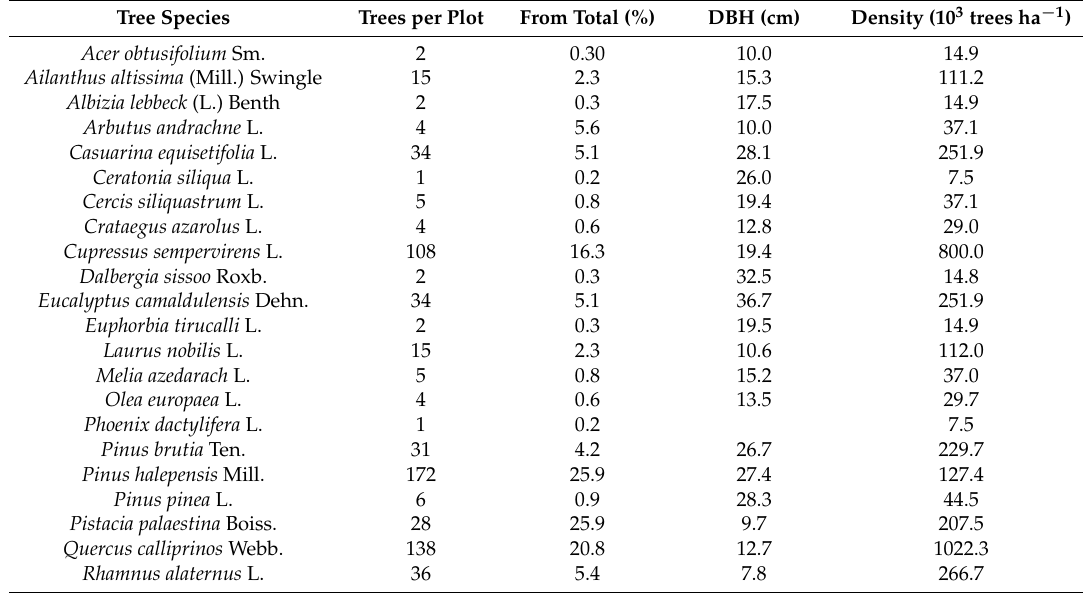
Table A1. Tree species distribution in urban (UR; top) and wildland (WLD; bottom) domains. Tree Species Trees per Plot From Total (%) DBH (cm) Density (10 3 trees ha − 1 ) Acer obtusifolium